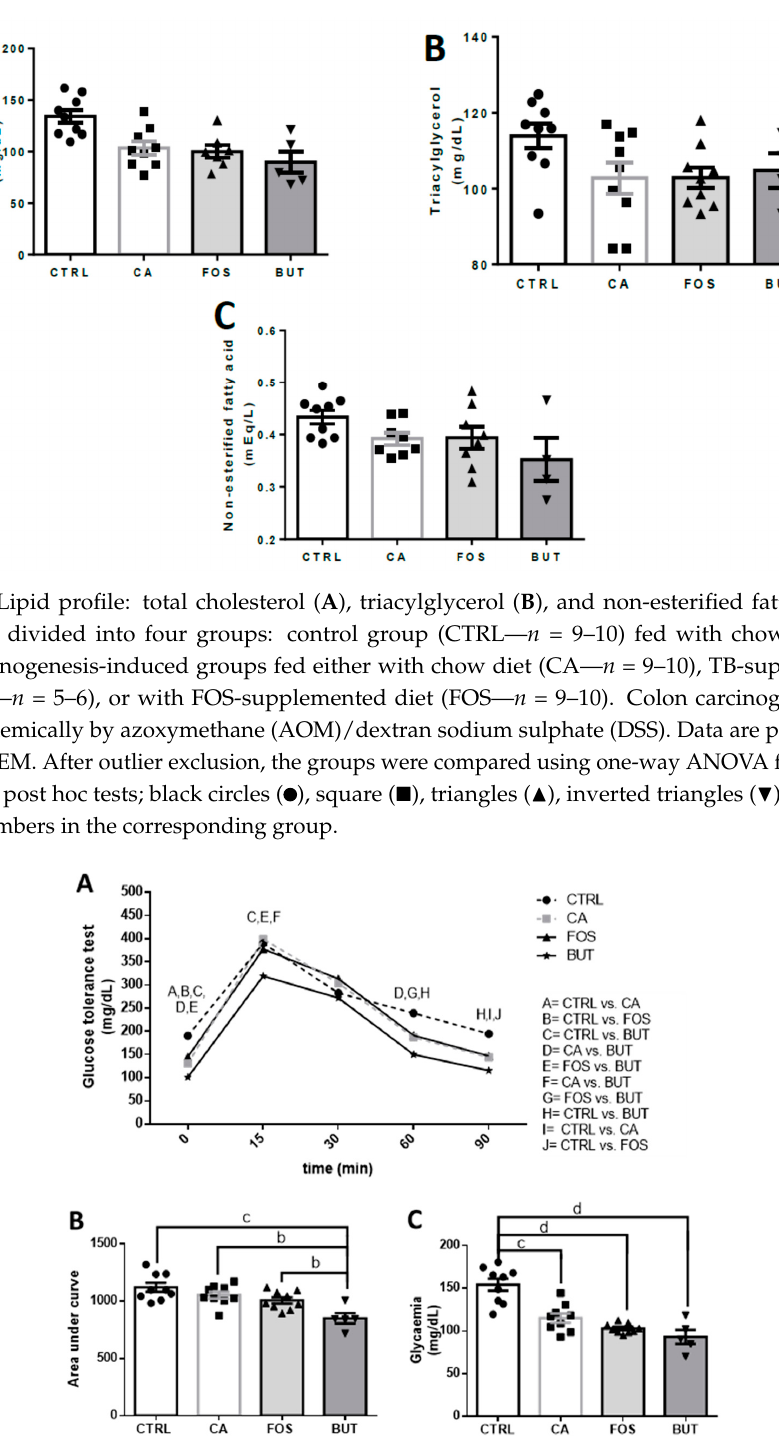
Figure 5. Butyrate reduces glycemia: glucose tolerance test ( A ), area under the curve ( B ), and glycaemia ( C ). Mice were divided into four groups: control group (CTRL— n = 9–10) fed with chow diet; and colon carcinogenesis-induced groups fed either with chow diet (CA— n = 9–10), TB-supplemented diet (BUT— n = 5–6), or with FOS-supplemented diet (FOS— n = 9–10). Colon carcinogenesis was induced chemically by azoxymethane (AOM)/dextran sodium sulphate (DSS). Data are presented as means ± SEM. The groups were compared using one-way ANOVA followed by Bonferroni post hoc tests; for p < 0.01 (b), p < 0.001 (c), and p < 0.0001 (d); black circles ( ), square ( (cid:4) ), triangles ( (cid:78) ), inverted triangles ( (cid:72) ) represents sample numbers in the corresponding